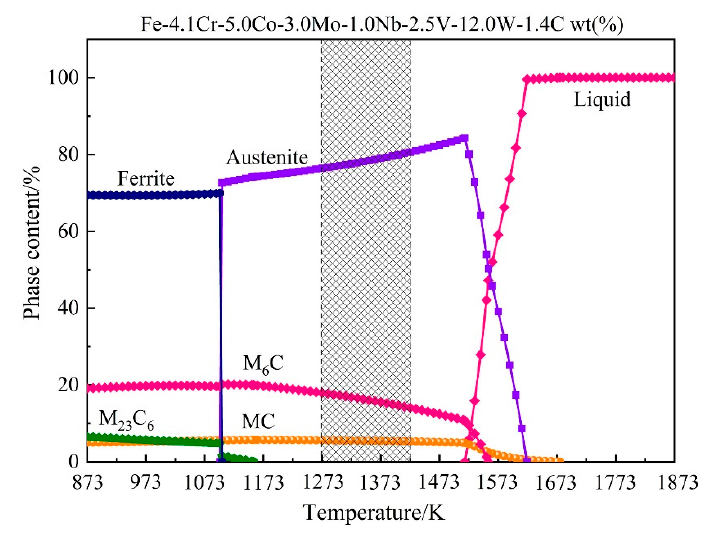
Figure 2. Phase equilibrium diagram of T15MN HSS at 873–1873 K.